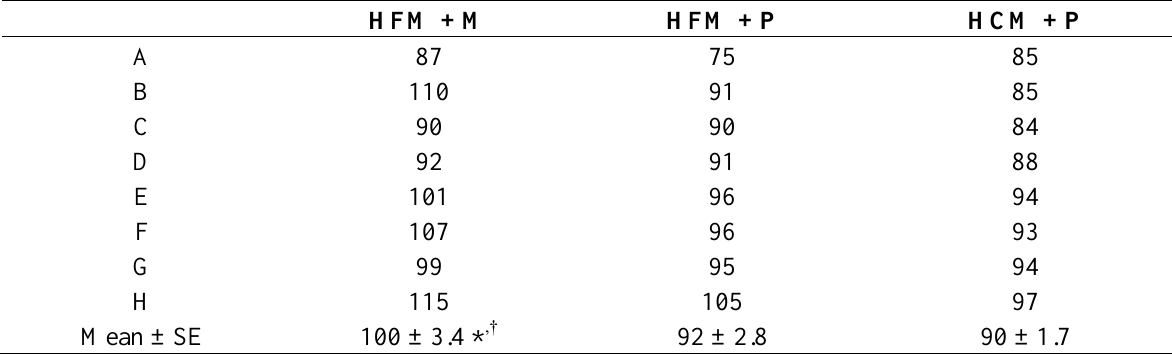
Table 2. Running time to exhaustion for three trials. HFM: high-fat meal; HCM: high-carbohydrate meal; M: maltodextrin; and P: placebo